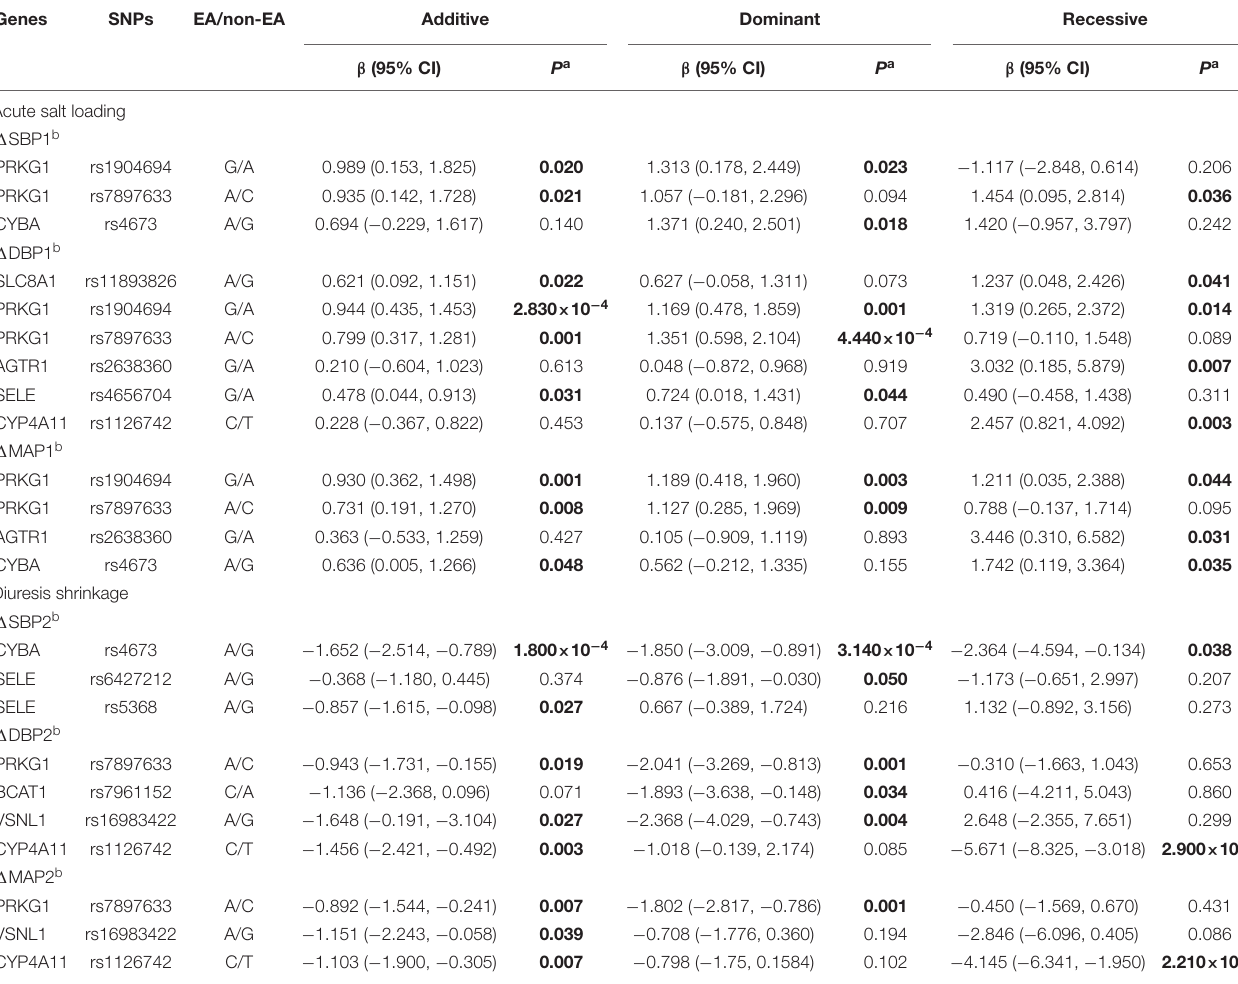
TABLE 2 | Associations between SNPs and BP change after acute salt loading and diuresis shrinkage. Genes SNPs EA/non-EA Additive Dominant